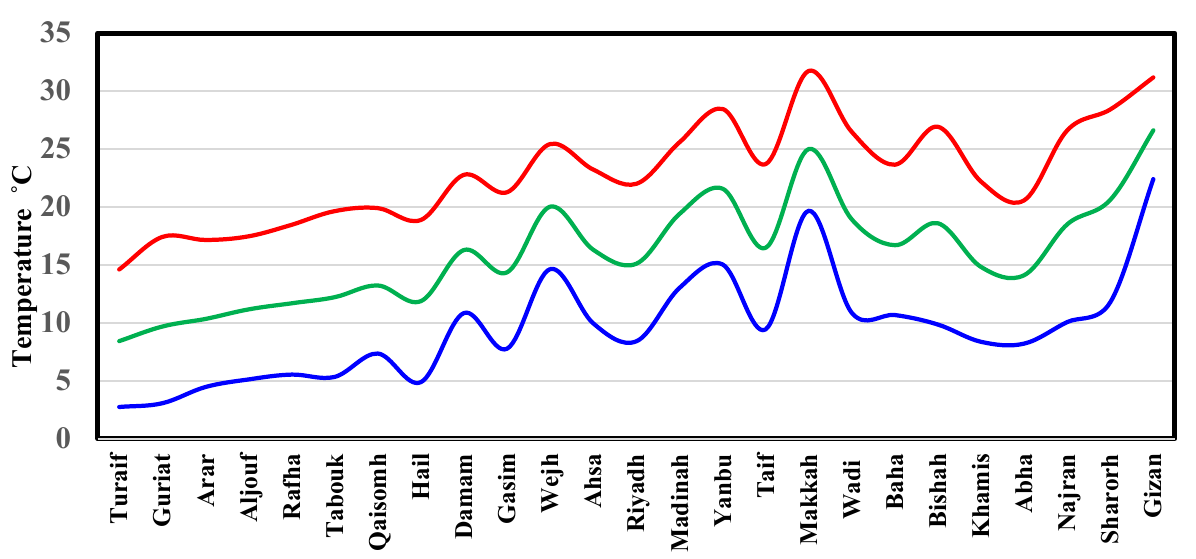
Figure 2. The average of mean (green line), maximum (red line) and minimum (blue line) values of air temperature of Saudi Arabia stations during the winter. The stations are arranged from north to south .